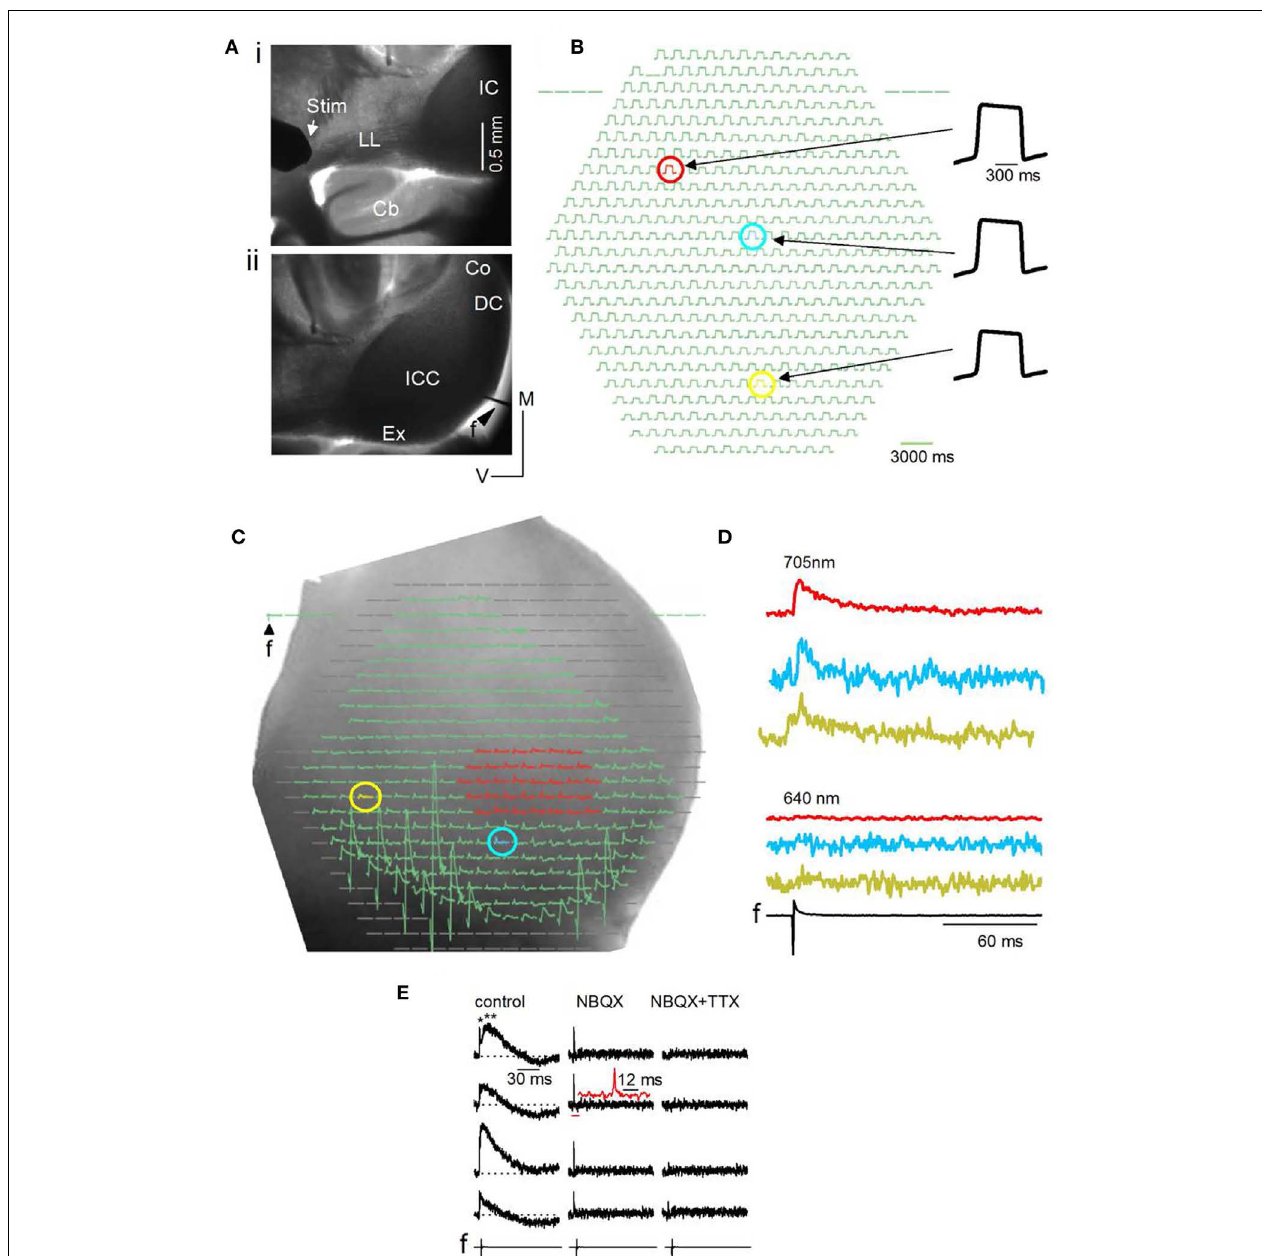
analysis are color-coded. Red, a group of multiple pixels over which responses are averaged; blue and yellow, different single pixels.The RLI has been subtracted before displaying this image. (D) VSD responses evoked by a single LL shock displayed as traces.Traces correspond to the red area and individual yellow and blue pixels selected in (C) . Absorbance measured through a 705nm filter (top) and a 640nm filter (bottom). f , field recording. (E) VSD signals evoked by a single LL shock are shown at different detectors covering the IC central nucleus. Left panel, normal ACSF; middle panel, 10 µ M NBQX (an antagonist of glutamatergic AMPA receptors); right panel, 10 µ M NBQX + 1 µ MTTX. LL shock strength 3mA. Left panel, top trace, single and double asterisks point to the first fast and second slower components; Inset, second trace from top, expanded region corresponds to the horizontal red bar;The 12ms scale bar is associated with the